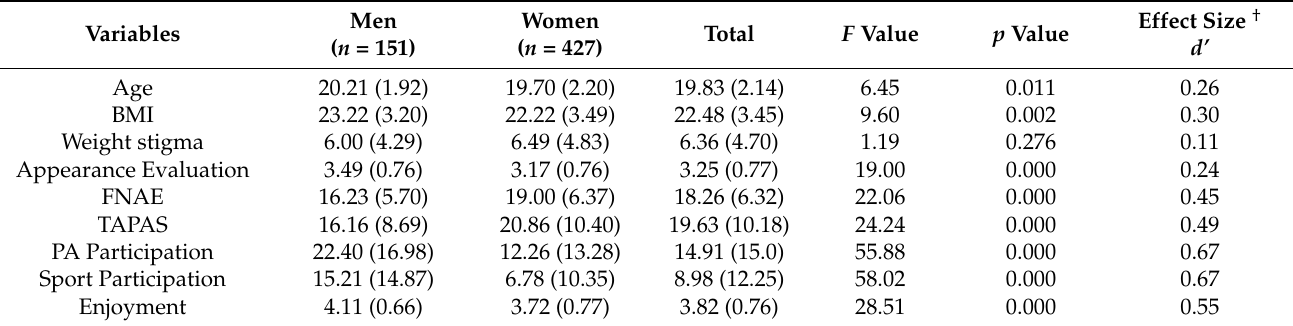
Table 1. Mean (SD) participant ratings for men and women on each of the variables along with F-values, significance levels, and effect sizes for group